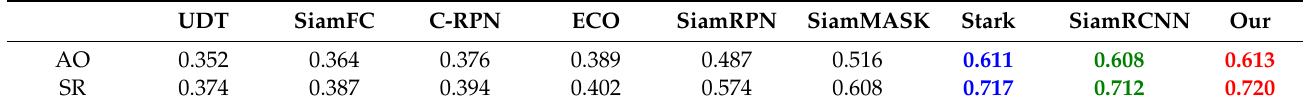
Table 4. Comparison with state-of-the-art trackers on GOT-10k ( Red , Blue, and Green represent the top three tracking effects and the larger the AO and SR, the better the tracking effect).